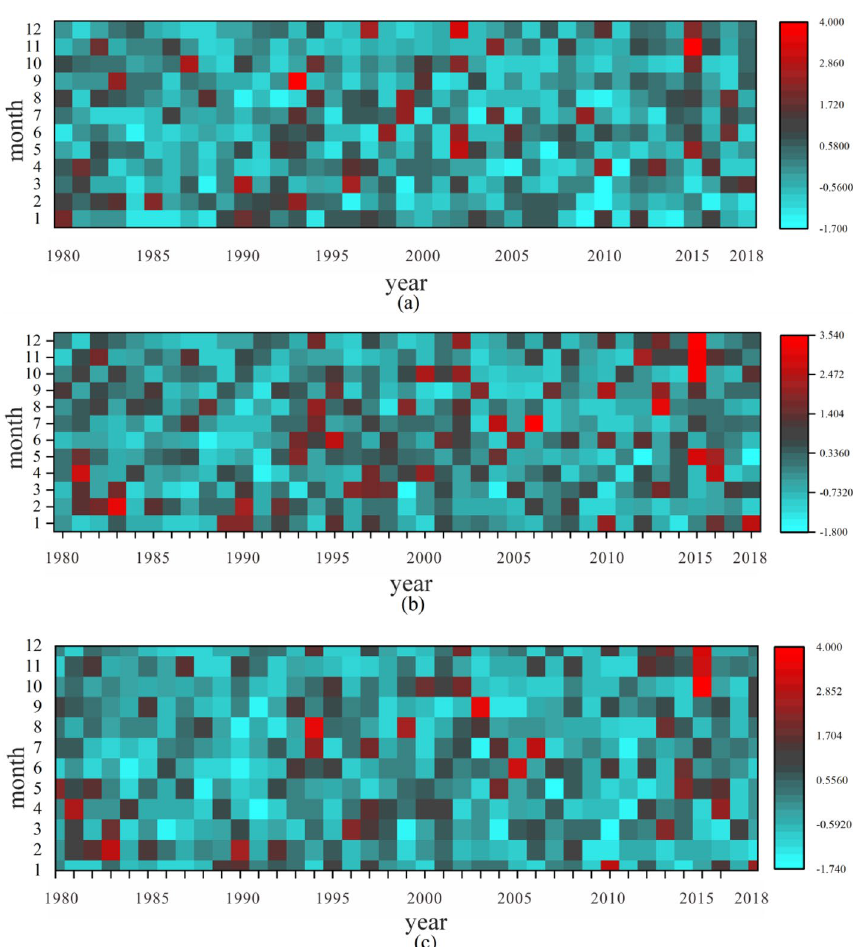
Figure 3. Heat map of interannual variation of precipitation in Lijiang River Basin ( a Guilin, b Pingle, c Lipu, d Xing’an, e Lingchuan, f